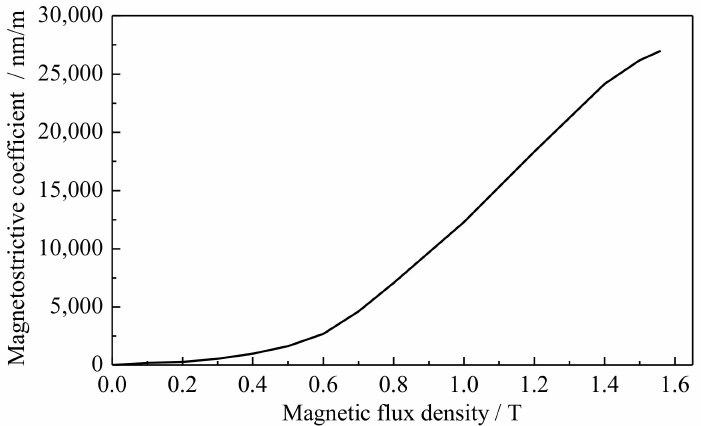
Figure 6. B– λ curve of amorphous alloy.